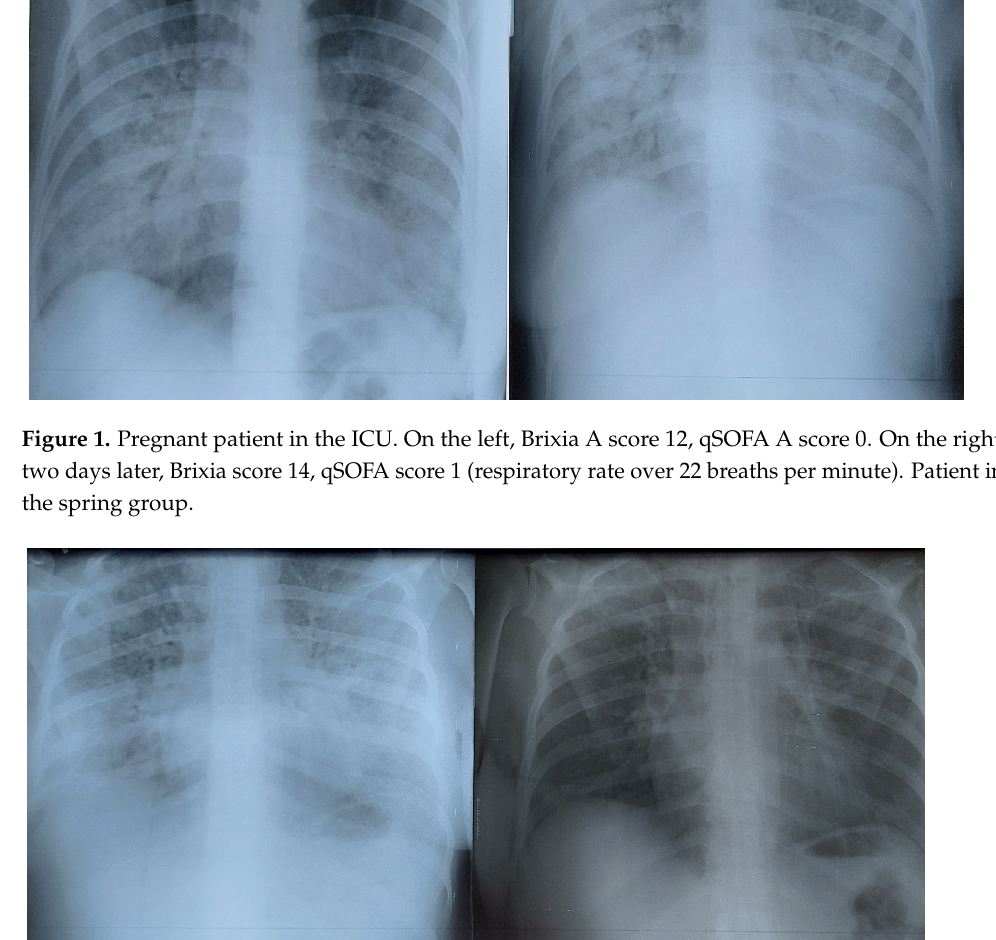
Figure 2. On the left, four days after the last image above, Brixia H score 15, Qsofa H score 0. On the right, one week later, Brixia E score 2, qSOFA E score 0. Same patient in the spring